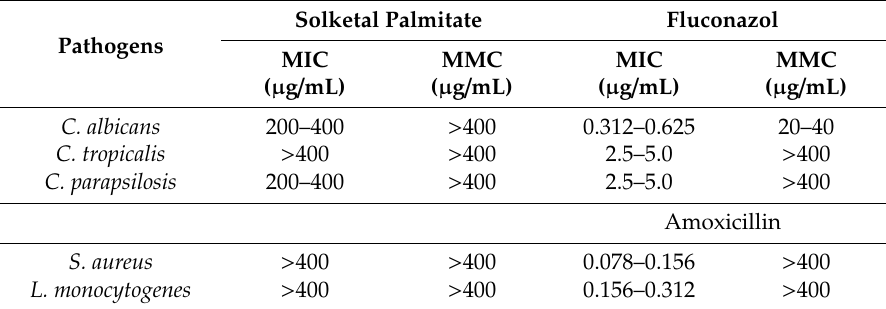
Table 6. Antimicrobial activity of solketal palmitate against several